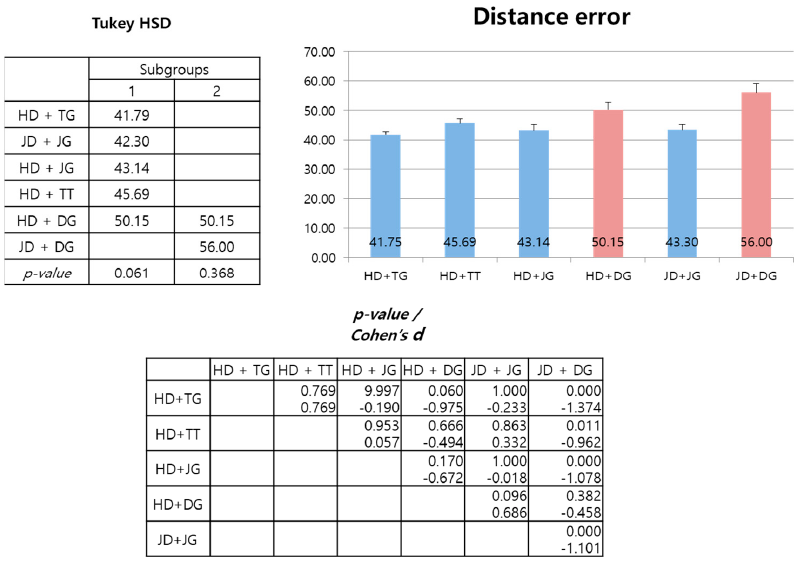
Figure 9. The average distance error to the center of the tunnel path among the six tested interfaces.